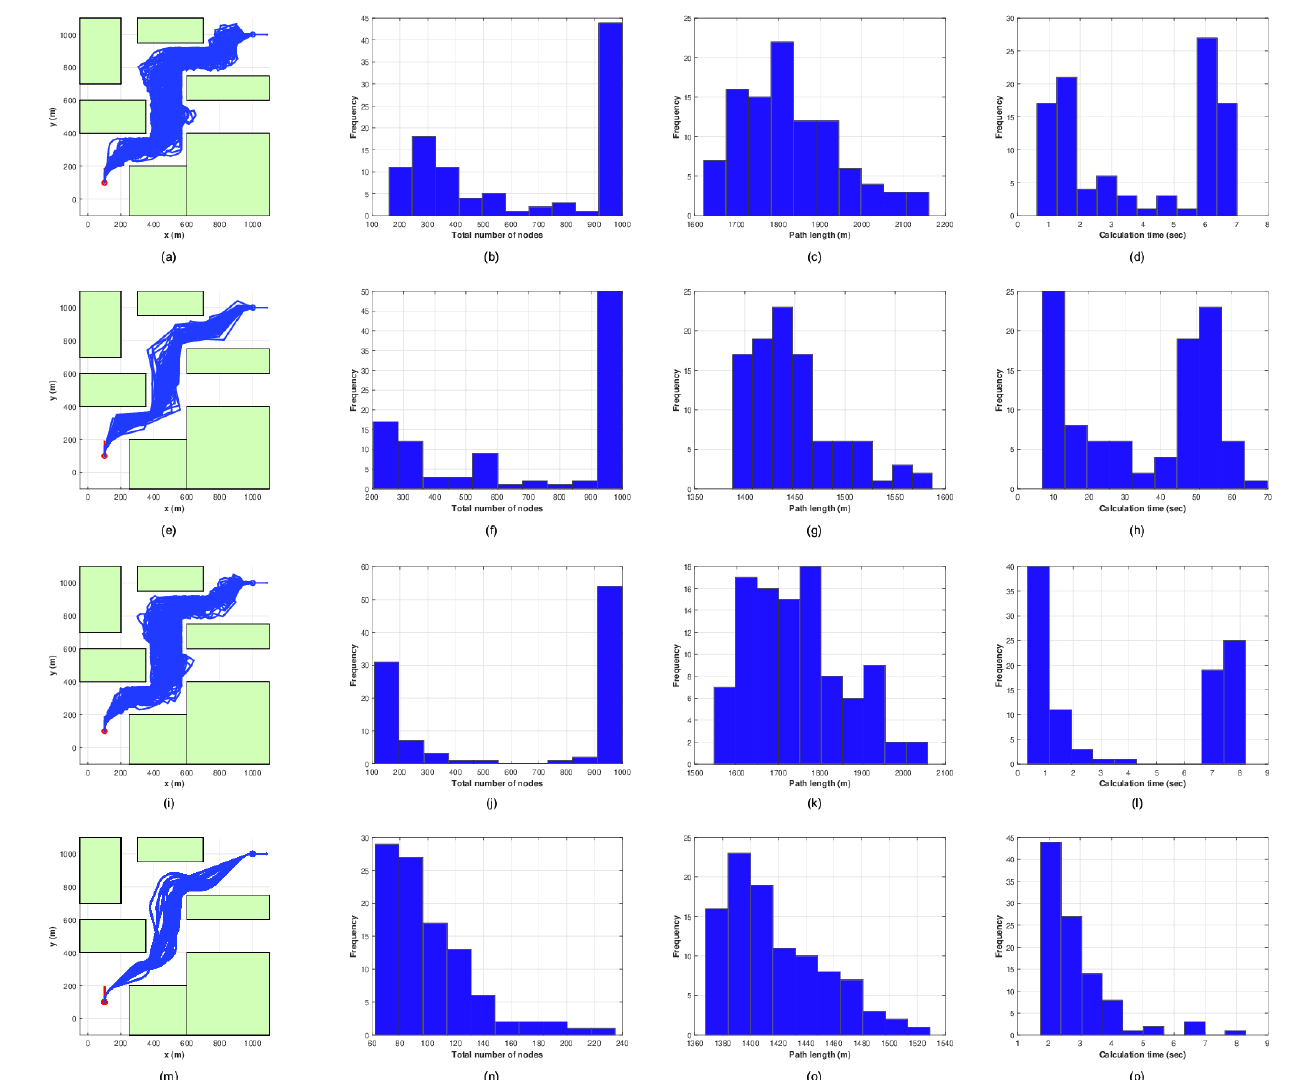
Figure 11. Results of scattered obstacles: ( a – d ) RRT. ( e – h ) RRT*. ( i – l ) Biased RRT. ( m – p ) Dubins